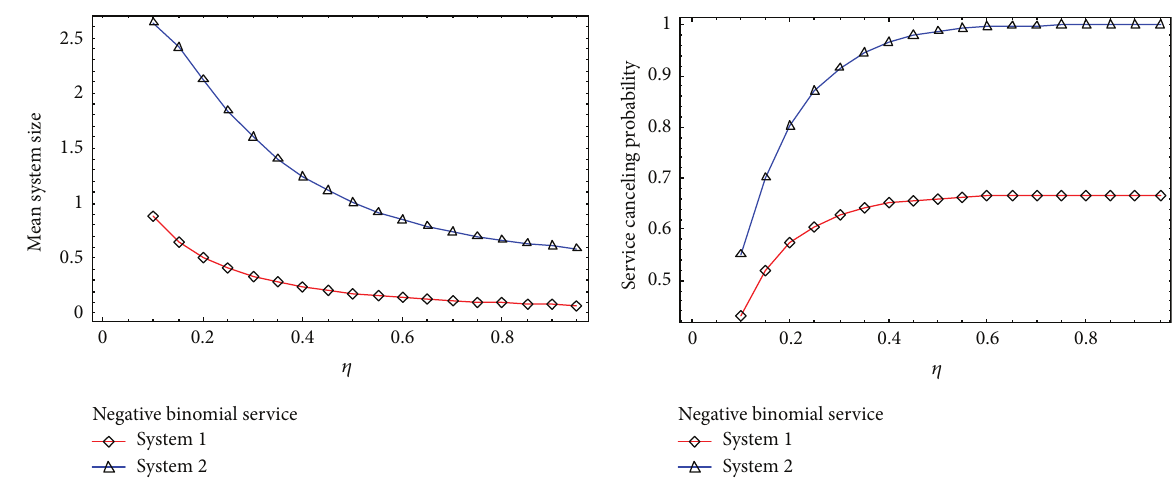
Figure 2: Mean system size and service canceling probability over 𝜂 with negative binomial service time distribution.